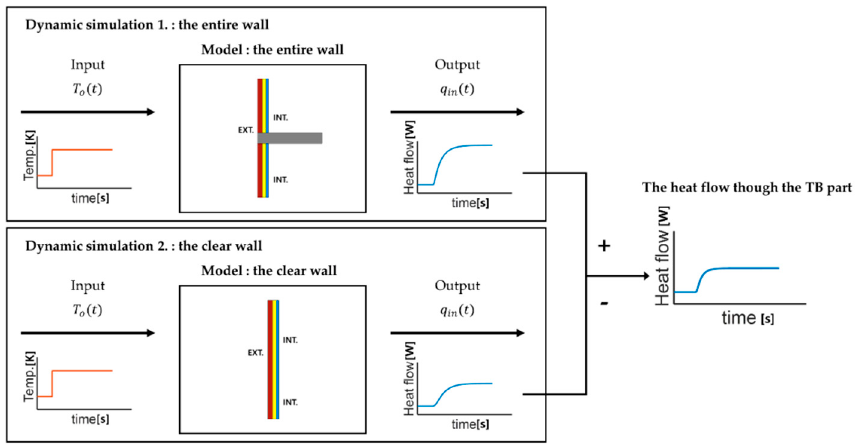
Figure 5. The method for obtaining the heat flow through the TB part. The heat flow through the TB part is calculated by subtracting the heat flow through the clear wall (dynamic simulation 2) from the heat flow through the entire wall (dynamic simulation 1). T o is the outdoor temperature and q in is the heat flow into the room.